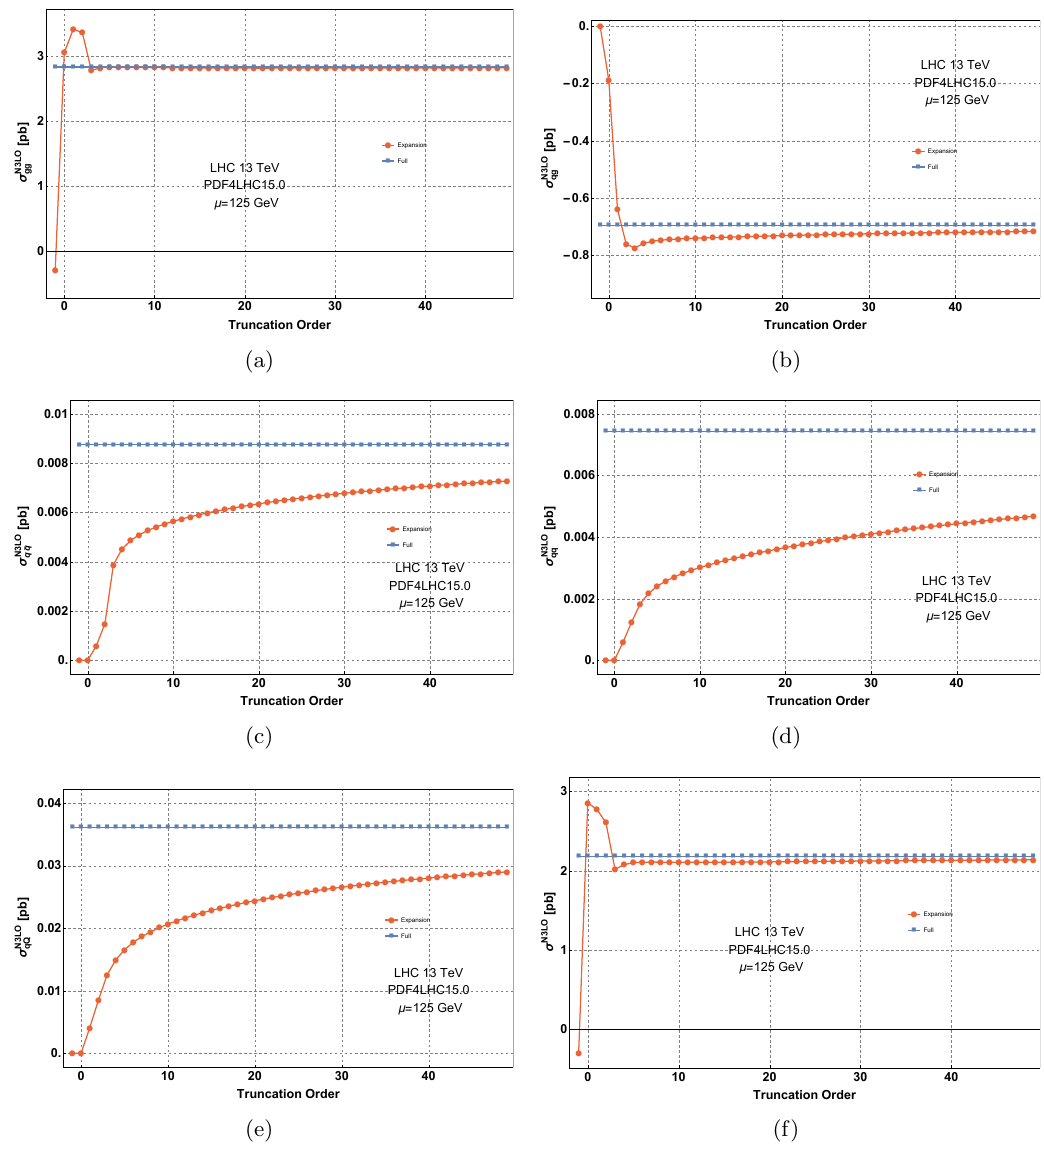
Figure 5 . The (cid:12)gure shows in red the contribution of the partonic coe(cid:14)cient function to the N 3 LO correction of the Higgs boson cross section approximated by a threshold expansion. The x-axis labels the order at which the expansion is truncated. The line in blue represents the contribution to all orders in the threshold expansion and is displayed as a reference. Figures (a), (b), (c), (d), (e) and (f) show the contribution due to the gg, qg, q(cid:22) q , qq, qQ initial state and the sum of all channels